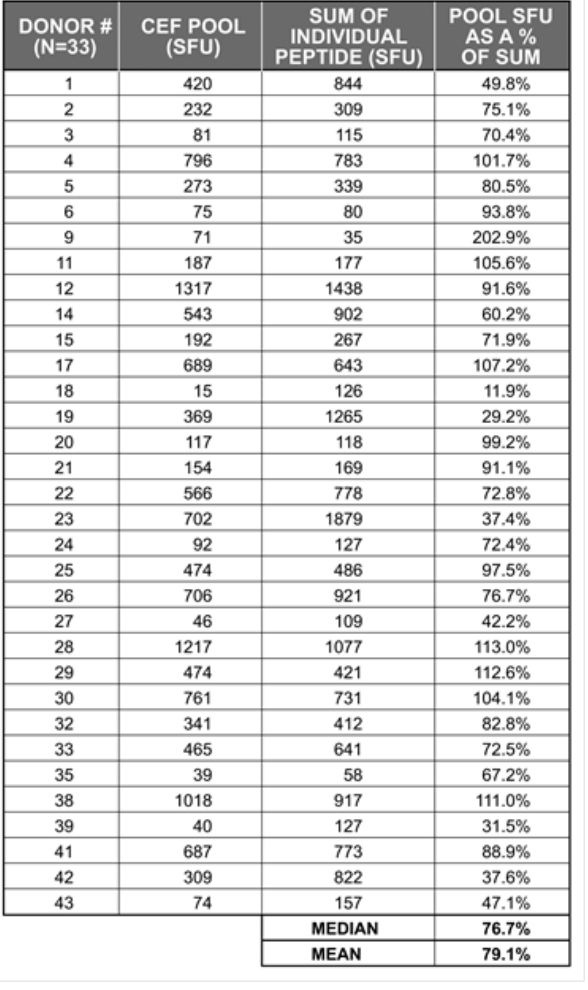
Table 2. Number of IFN- γ SFU elicited by the CEF -pool (32 peptides in a